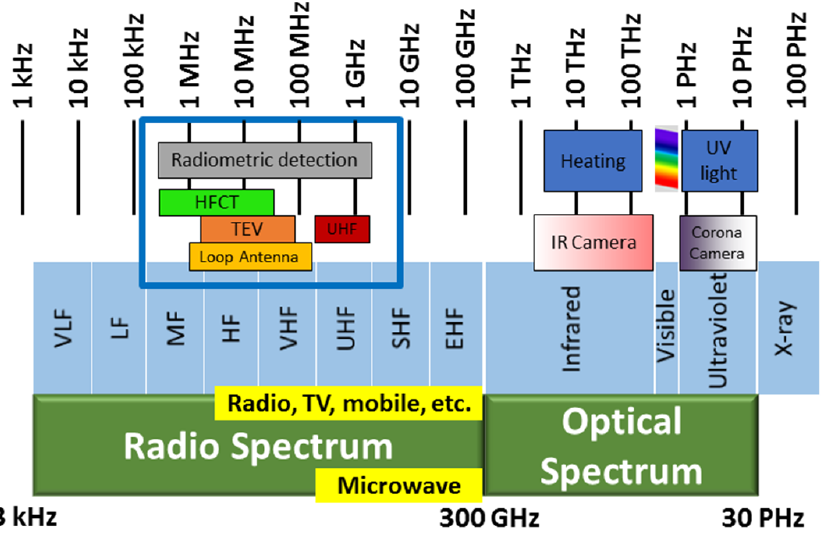
Figure 4. Location of the different radio and optical detection methods on the electromagnetic